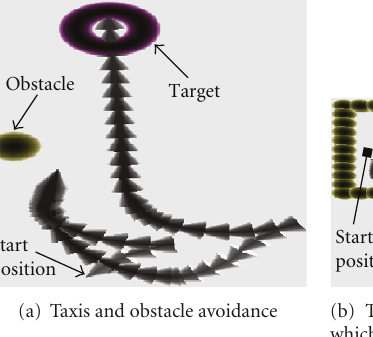
Figure 9: Single agent simulation results.